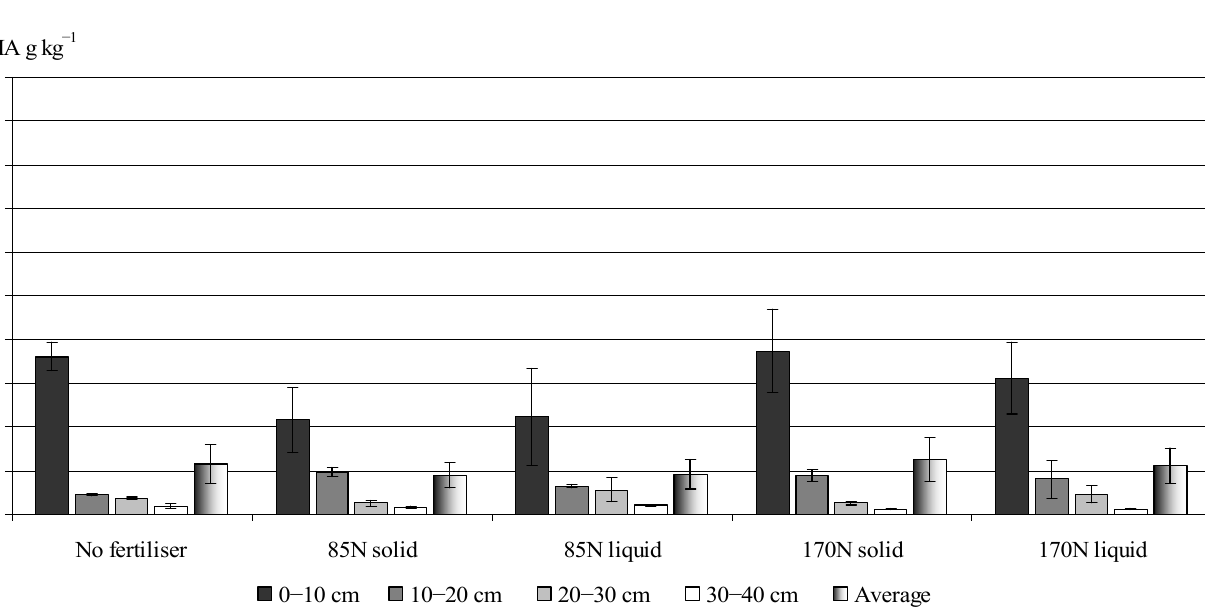
Figure 19. MHA content in grassland in Retisol, 2020.